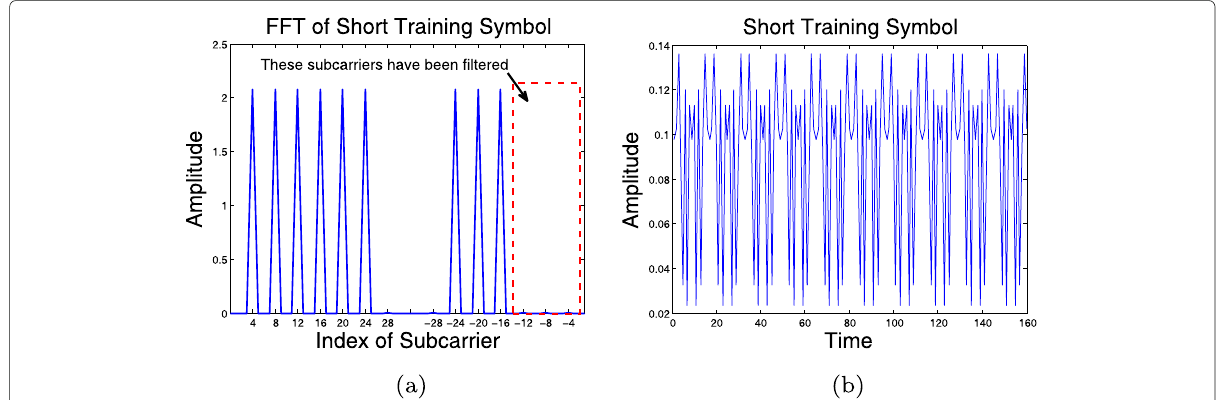
Fig. 9 After filtered interfered subcarriers out, the periodicity of short training symbols is recovered. a FFT of filtered STS. b Filtered STS